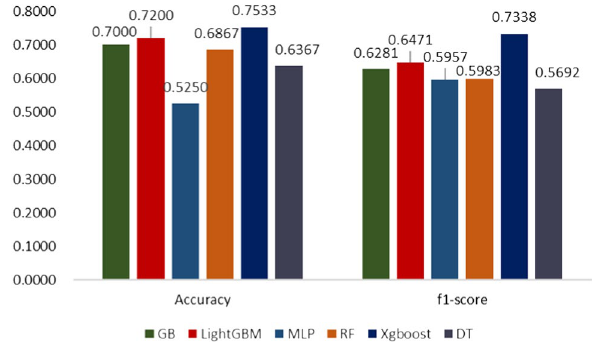
Fig. 3 Comparison of the accuracy and the F1-score of each